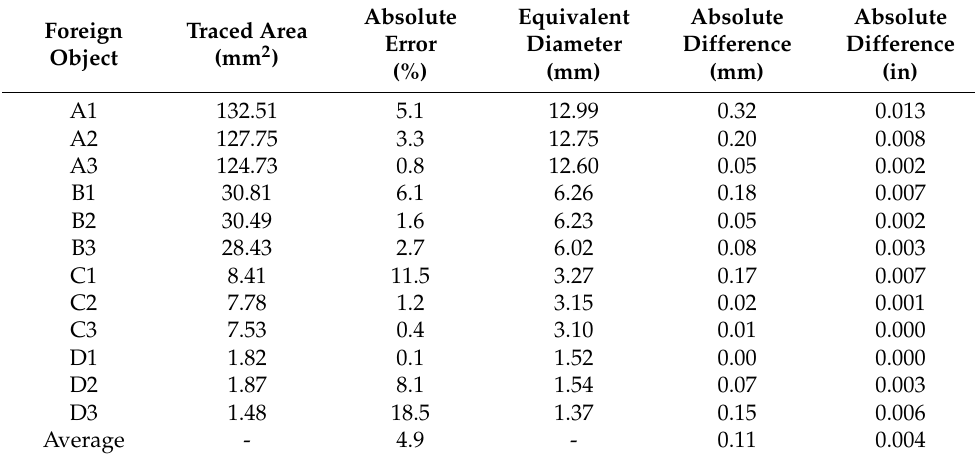
Table 3. Summary of Ultrasonic Measurements using